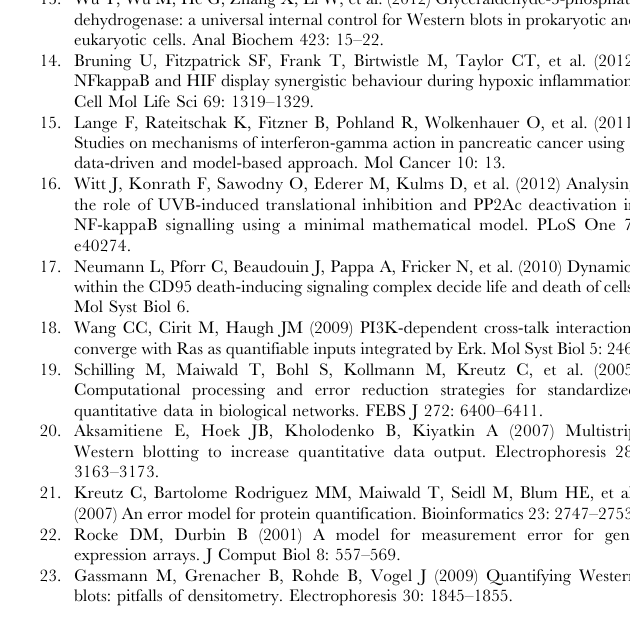
Figure S8 Correlation between the intensity of the normalisation points and the CV of the normalised data. Using data from the three replicates of the ERK dilution experiments detected with CCD imager, we tested every point on a blot as normalisation point. For each resulting normalisation we computed the average of the CV of the normalised data points, and plotted the value of each data point (scaled so that the maximum of each replicate is equal to 1) against the average CV obtained by normalising with the corresponding data point. The result shows how the intensities of each normalisation point chosen correlate with the variability of the normalised data. (TIFF) Information S1 Data and statistical analysis of dilution experiments for BSA, ERK, RSK1 and